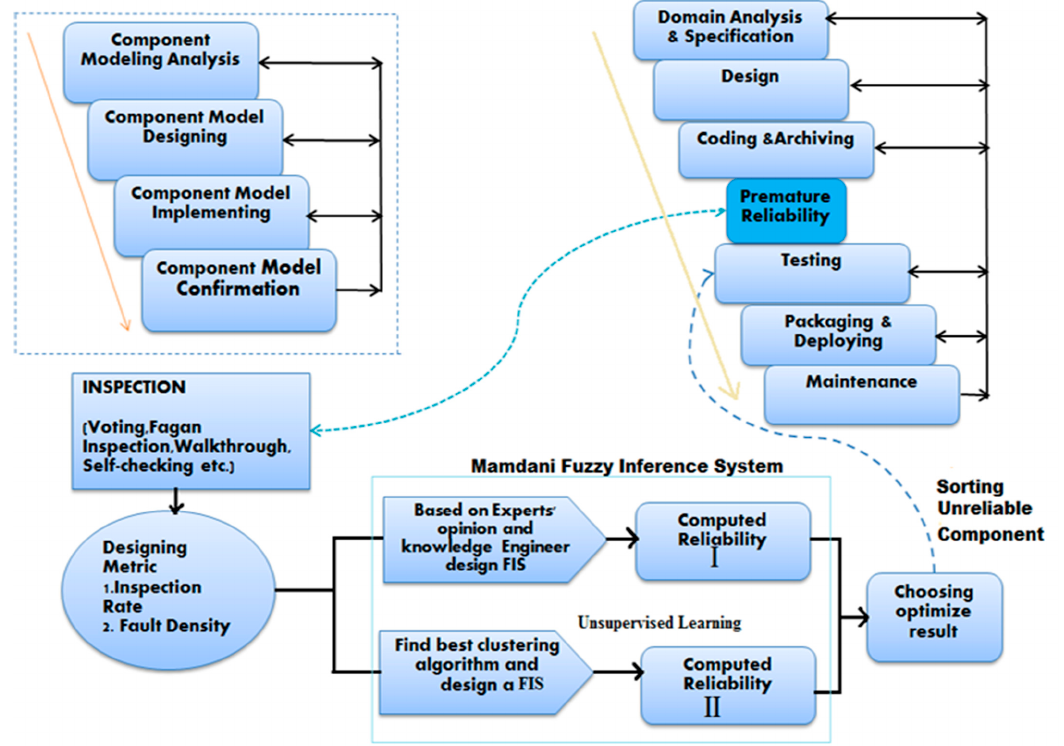
Figure 2. A Mamdani inference novel proposed model.